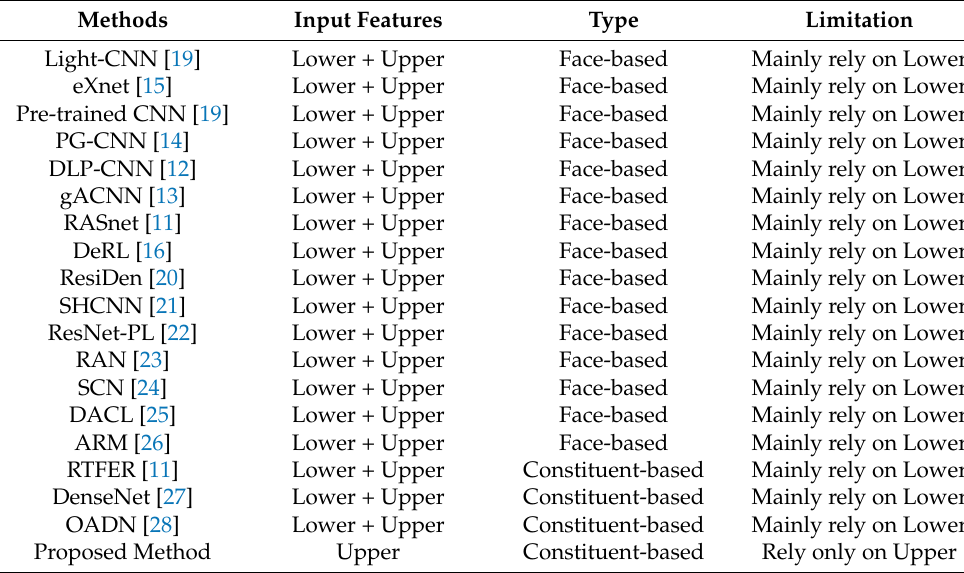
Table 1. Comparison of input features and type of